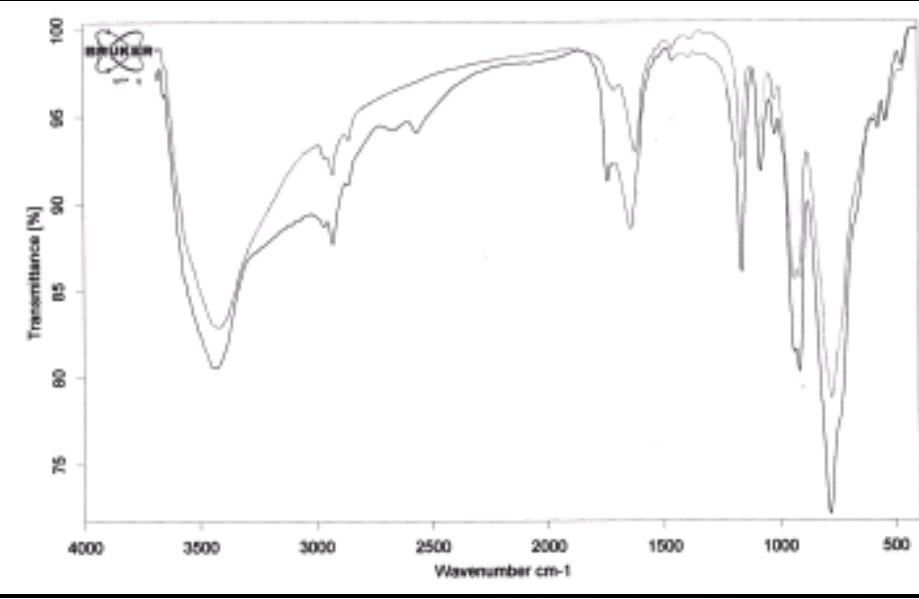
Figure 2. IR spectrum of Preyssler ’s anion before (a) and after (b)